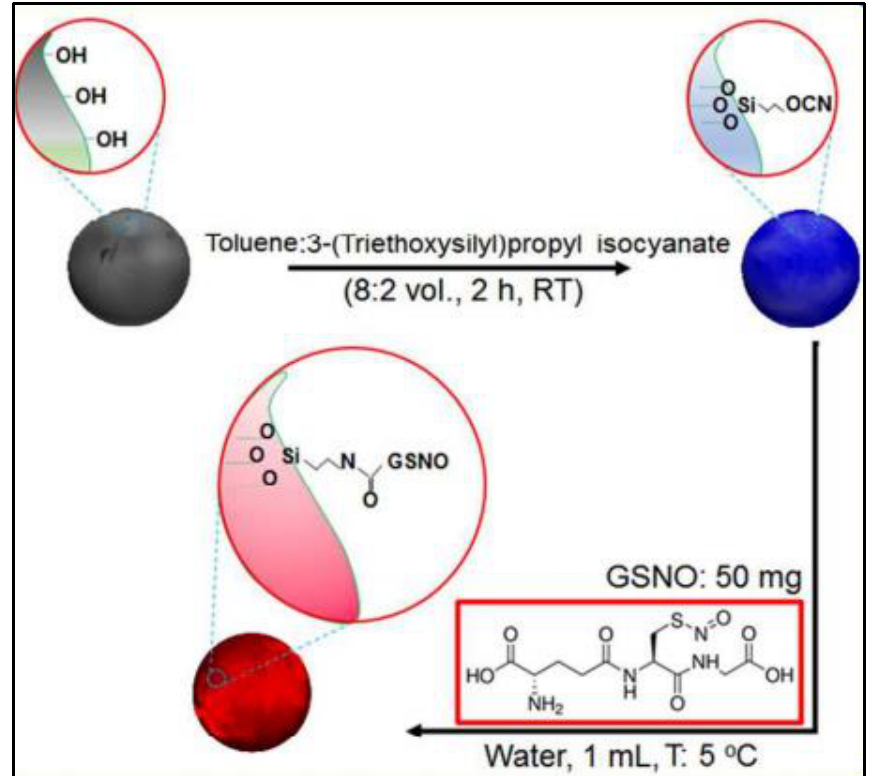
12 of 16 Figure 8. Synthesis scheme of GSNO-conjugated poly (lactic-co-glycolic acid) (GSNO-PLGA) [69]. For controlled release purpose, GSNO is conjugated on the surface of porous silicon nanoparticles (pSiNPs) as outlined in Figure 9. In this study, the release of NO is triggered